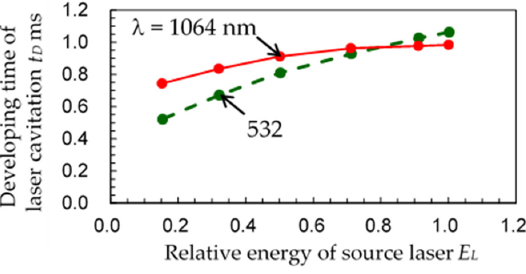
Figure 5. Developing time of laser cavitation as a function of the relative energy of the source la- ser.